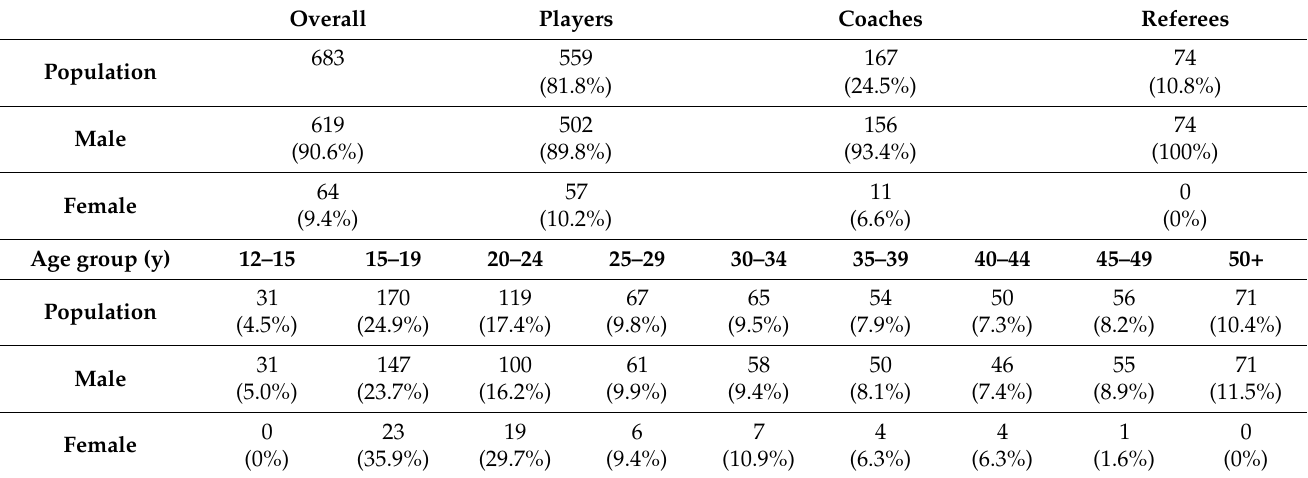
Table 1. Characteristics of the study population in the whole population and according to the type of participant {n (%)}. Bold: categories and age groups.